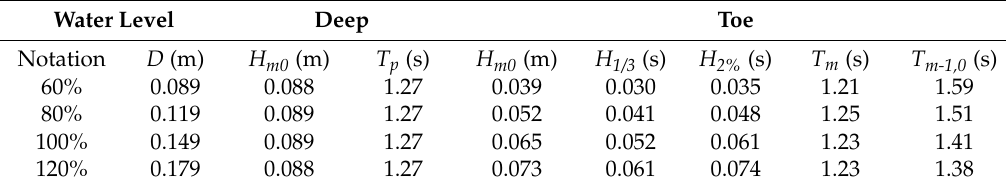
Table 1. Measured wave conditions at deep water and at the base.